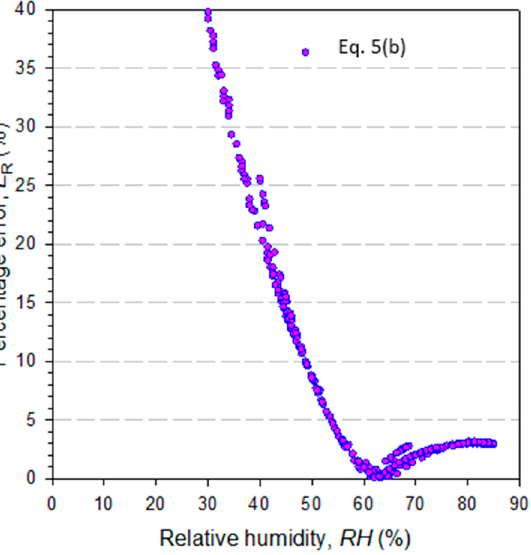
Figure 10. Percentage error, E R (%), in the approximated value of T dp (estimated by using Equation (5b)) as affected by relative humidity ( RH ).